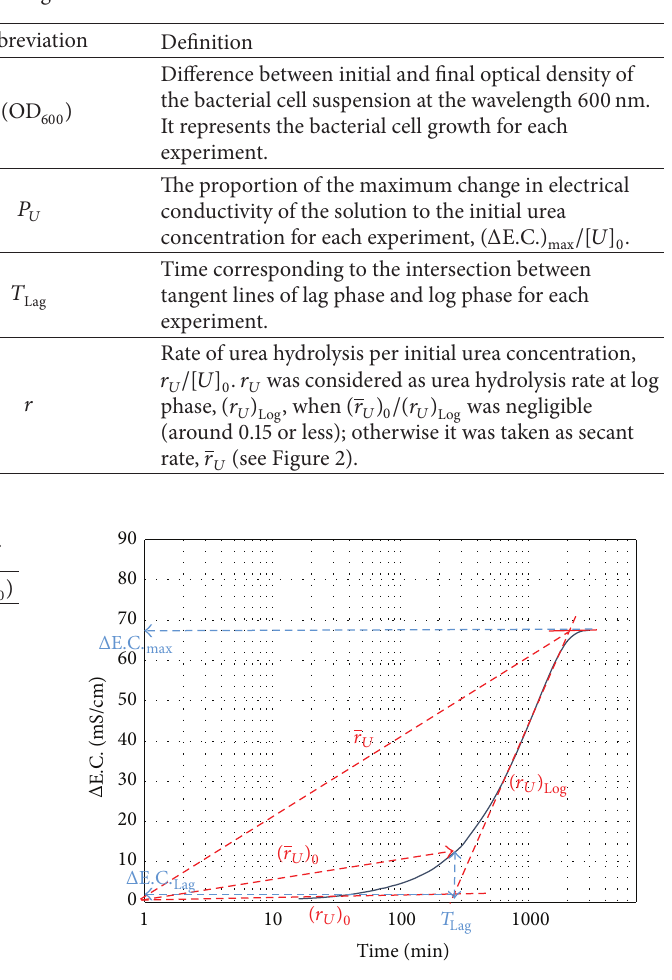
Table 2: Responses investigated and their definitions.